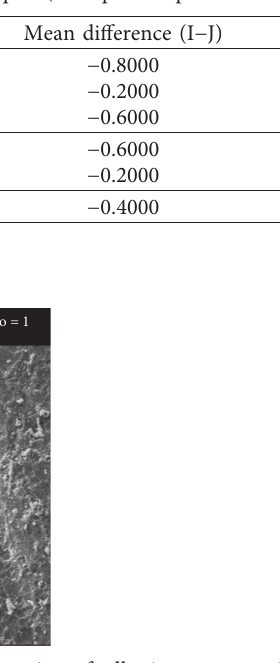
Table 5: Multiple comparison tests for ARI among different techniques (multiple comparison ARI).